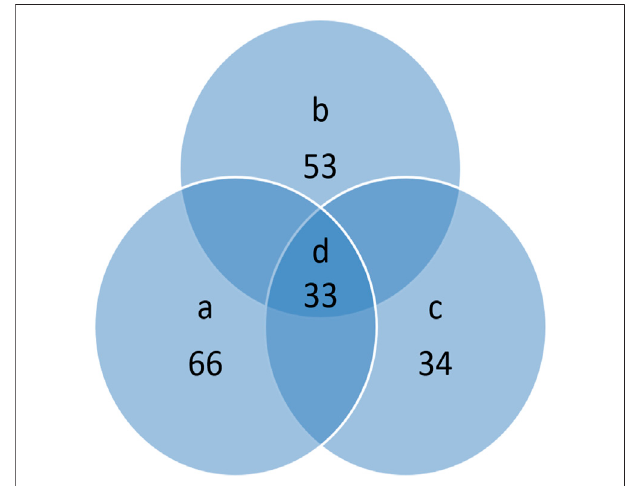
FIGURE 1 | Comparison of actual number of detected peptides with theoretical